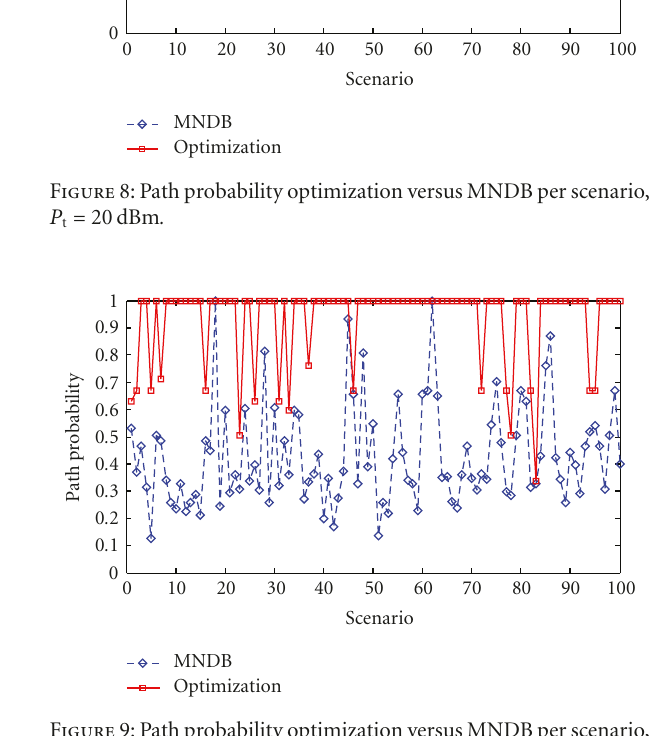
Figure 9: Path probability optimization versus MNDB per scenario, P t = 18 dBm